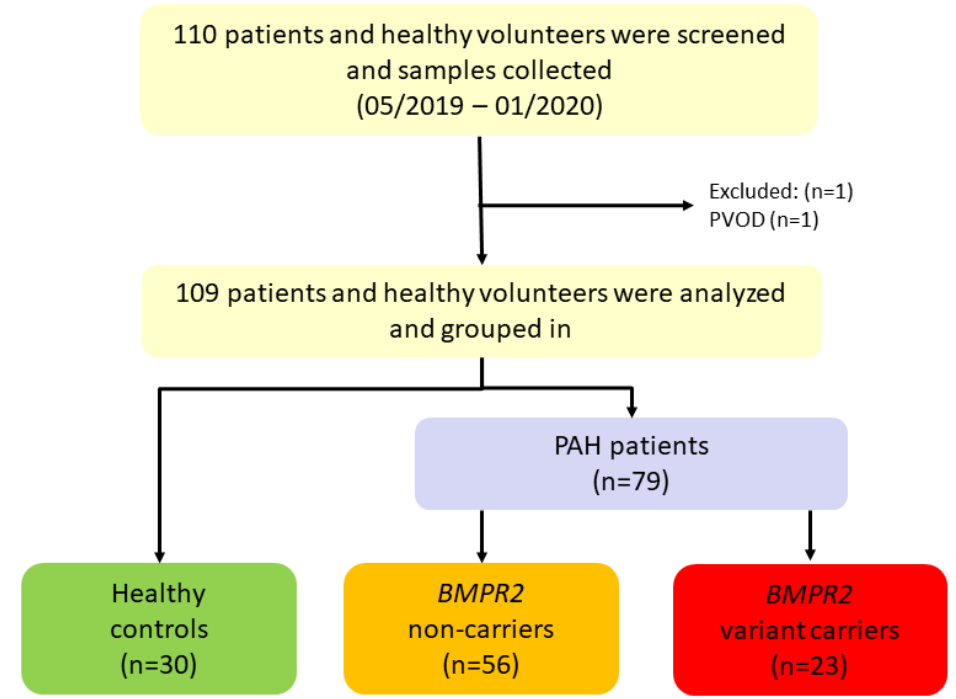
Figure 1. Recruitment of study population from May 2019 to January 2020. 110 participants were screened, and samples were collected of which 109 were analyzed and included. BMPR2 : bone morphogenetic protein receptor type II, PAH: pulmonary arterial hypertension, PVOD: pulmonary veno-occlusive disease.